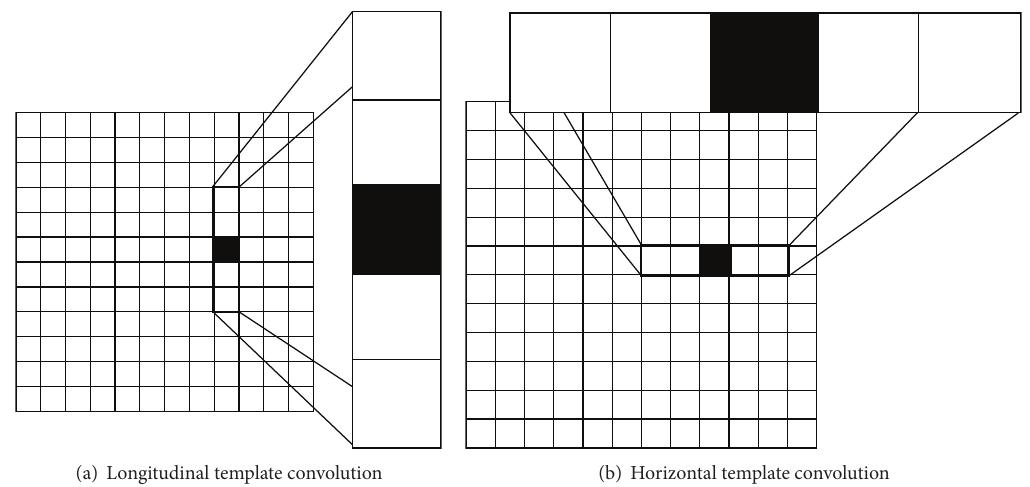
Figure 2: Schematic diagram of the separability of Gaussian function convolution.